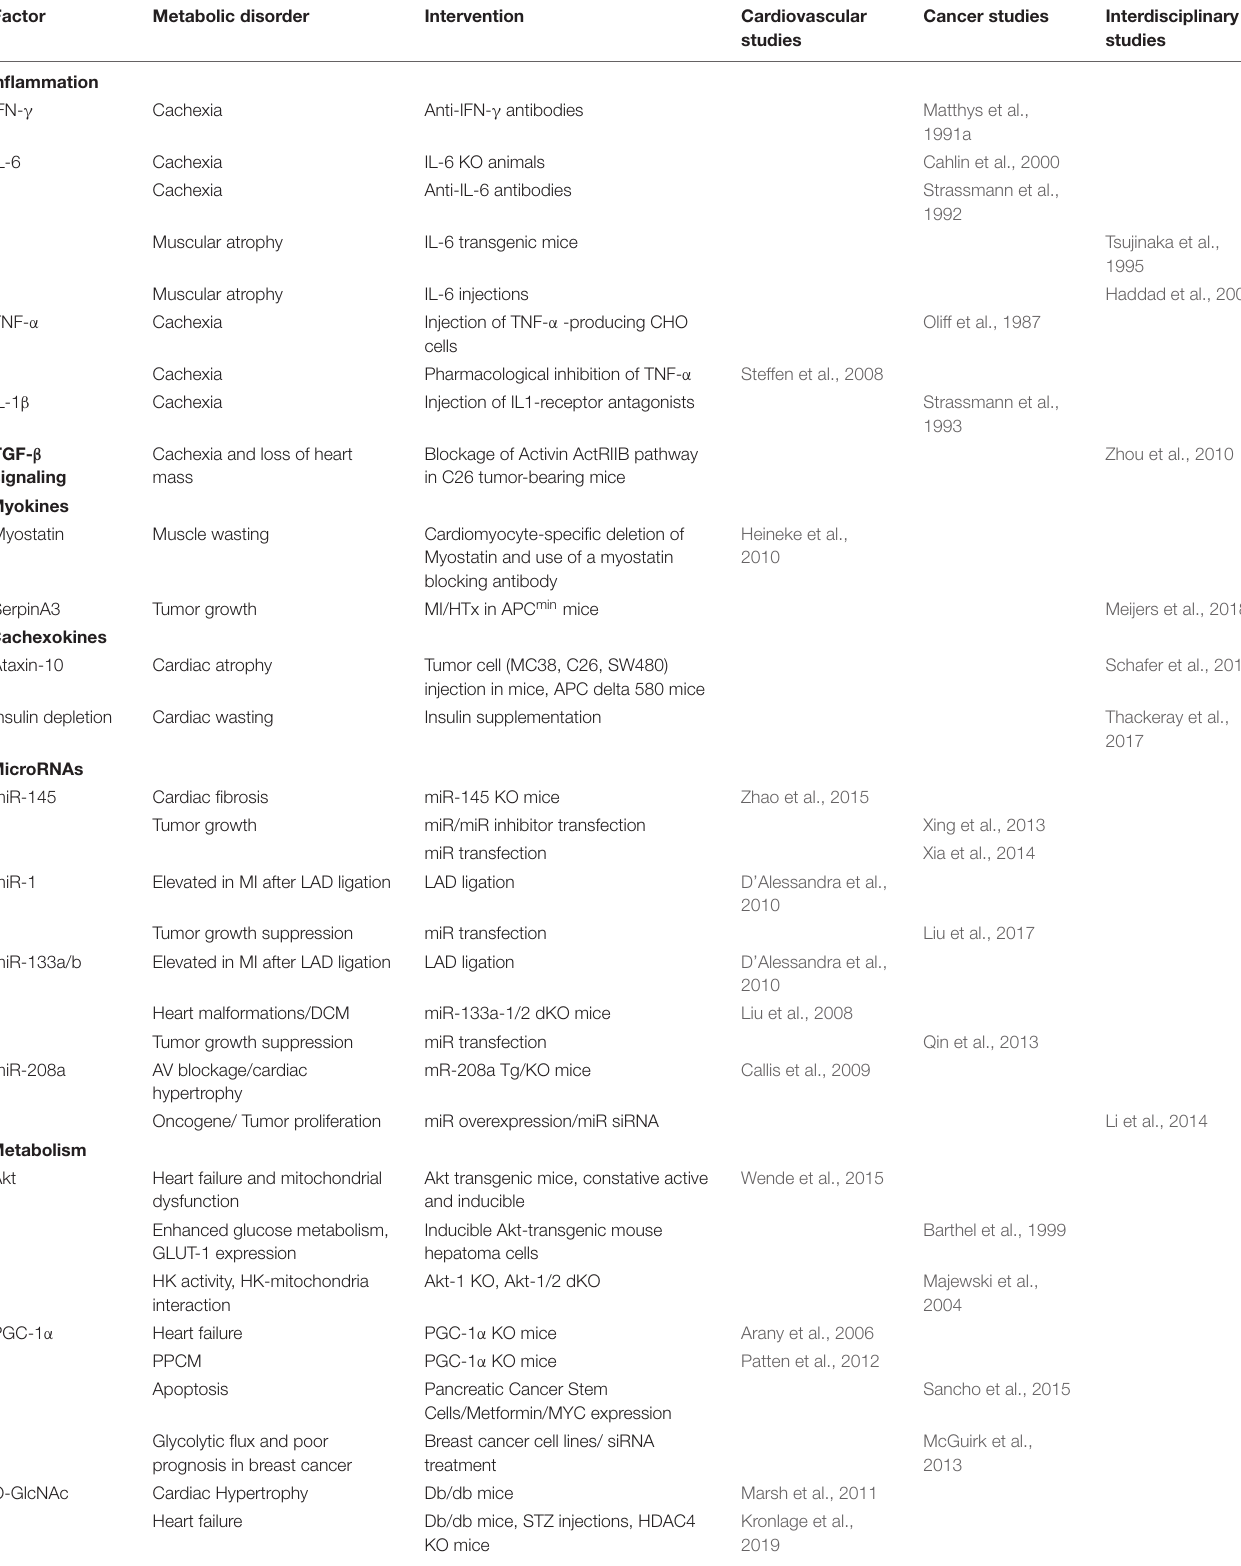
TABLE 1 | Preclinical models that describe metabolic alterations in heart disease, cancer, and link both diseases (interdisciplinary